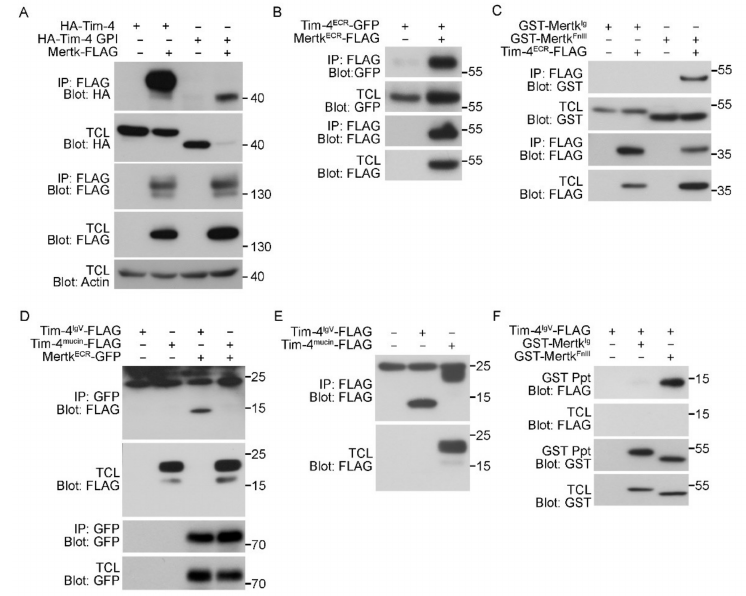
Figure 3. The IgV domain of Tim-4 binds to the fibronectin type III domain of Mertk. ( A – C ) 293T cells transfected with the indicated plasmids were lysed and incubated with anti-FLAG antibody-conjugated agarose beads. Bound proteins were detected by immunoblotting (( A ), n = 3; ( B ), n = 3; ( C ), n = 3). ( D ) The lysates of 293T cells transfected with the indicated plasmids were incubated with an anti-GFP antibody and protein A / G agarose beads. Bound proteins were detected by immunoblotting ( n = 3). ( E ) 293T cells transfected with the indicated plasmids were lysed and incubated with anti-FLAG-conjugated agarose beads. Bound proteins were detected by immunoblotting. Noticeably, the IgV domain of Tim-4 was only detected in immunoprecipitants but not in total cell lysates ( n = 2). ( F ) 293T cells transfected with the indicated plasmids were incubated with glutathione-sepharose beads. Bound proteins were detected by immunoblotting ( n = 3). TCL, total cell lysate; IP,